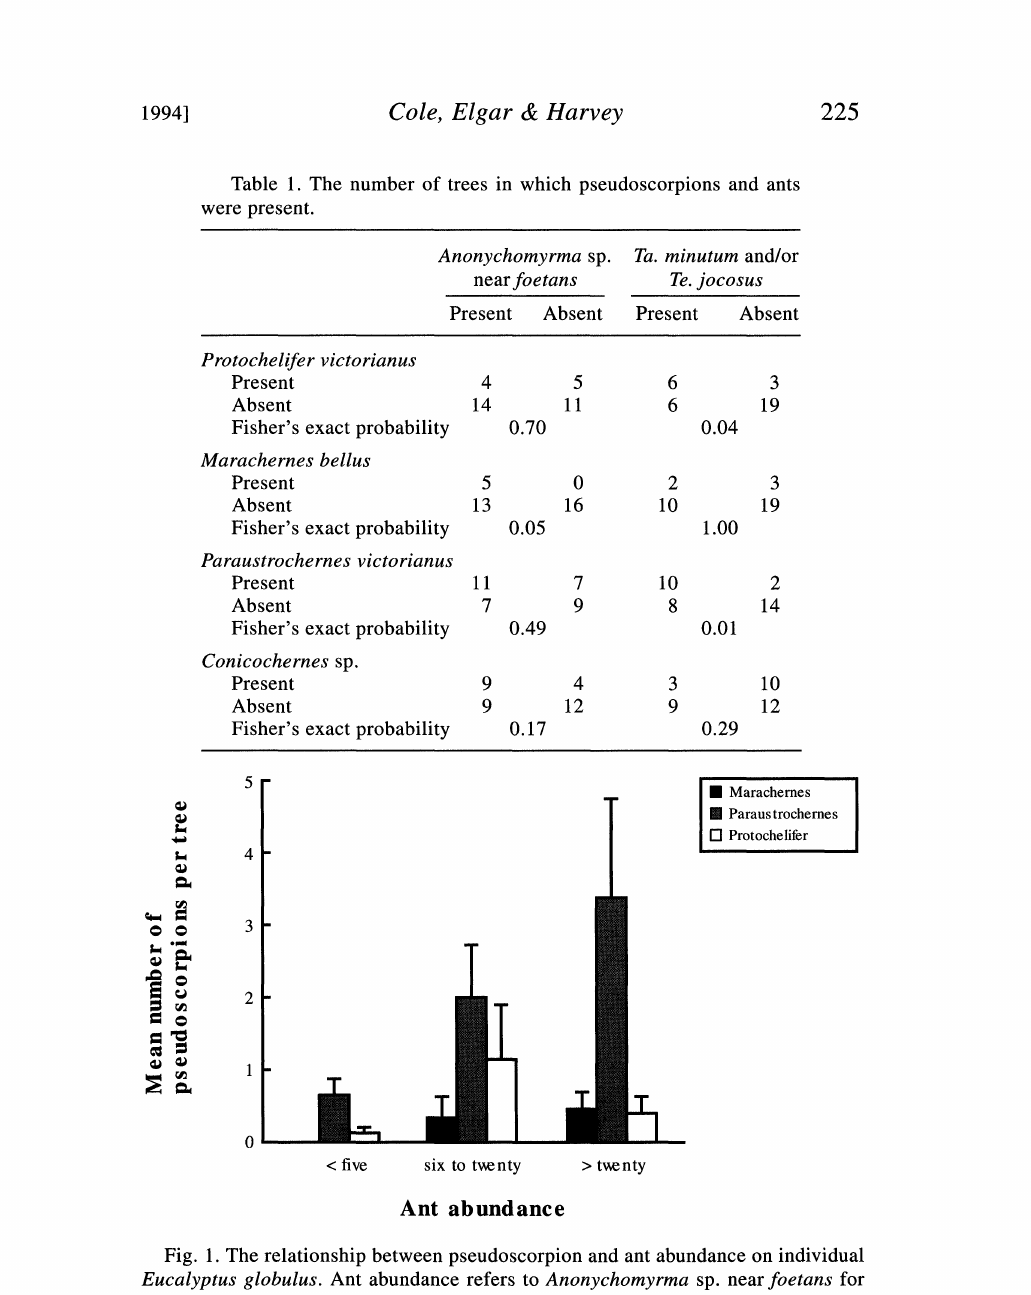
Fig. 1. The relationship between pseudoscorpion and ant abundance on individual Eucalyptus globulus. Ant abundance refers to Anonychomyrma sp. near foetans for Marachernes bellus, and Tapinoma minutum and/or Technomyrmex jocosus for Paraustrochernes victorianus and Protochelifer